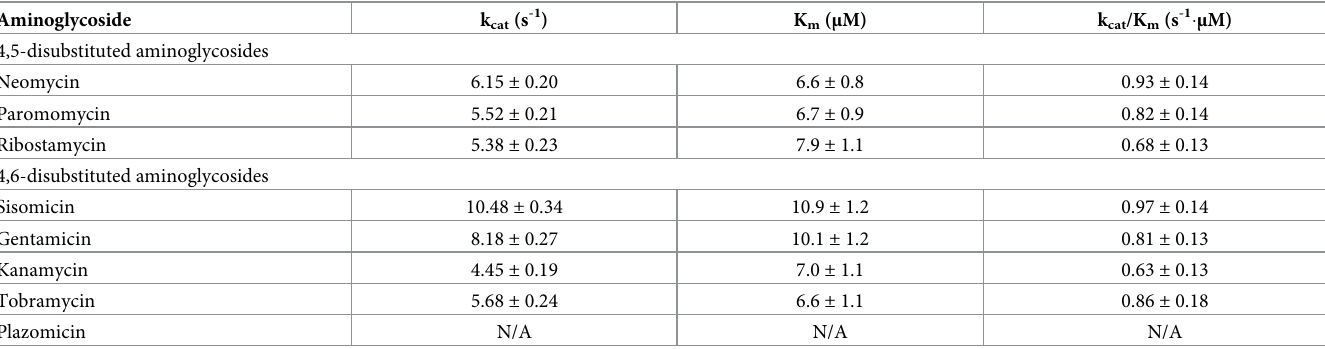
Table 4. Kinetic parameters for